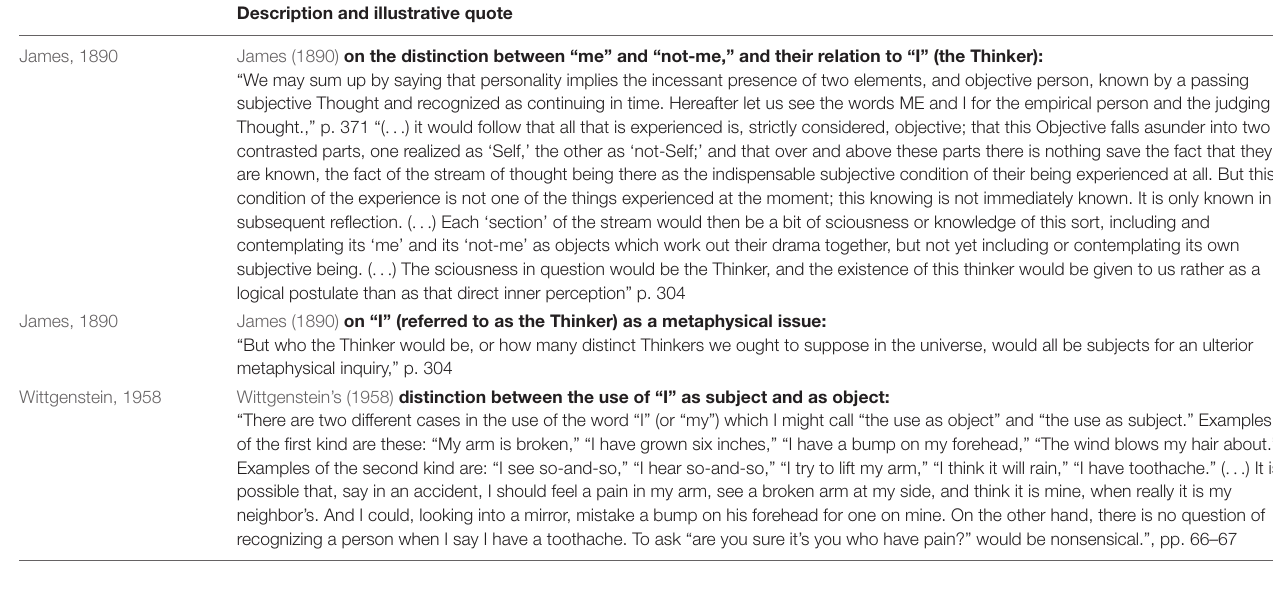
TABLE 1 | Quotes from James (1890) illustrating the distinction between self-as-object (“Me”) and self-as-subject (“I”) and a quote from Wittgenstein (1958) illustrating his distinction between the use of “I” as object and as subject.